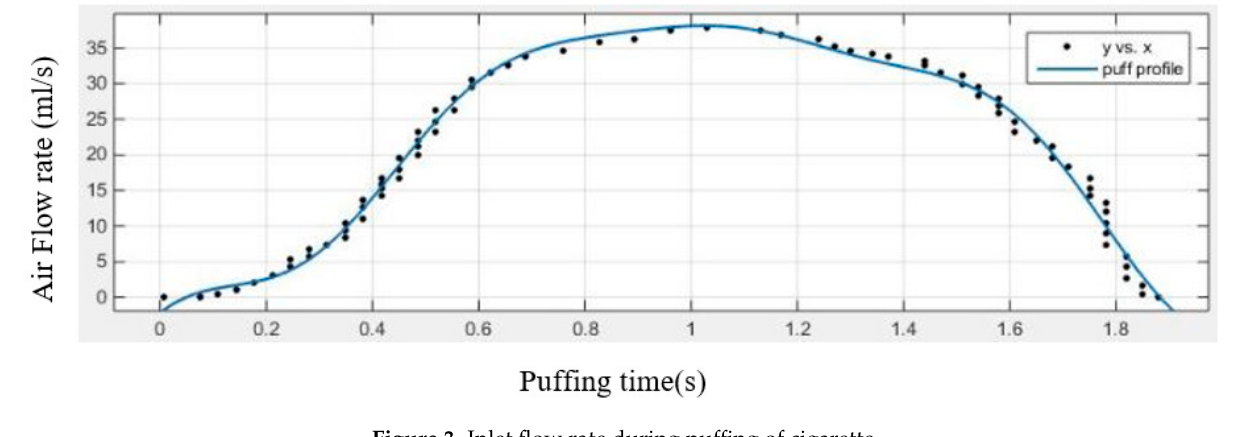
Figure 3 represents inlet air flow rate profile during puffing of the cigarette.